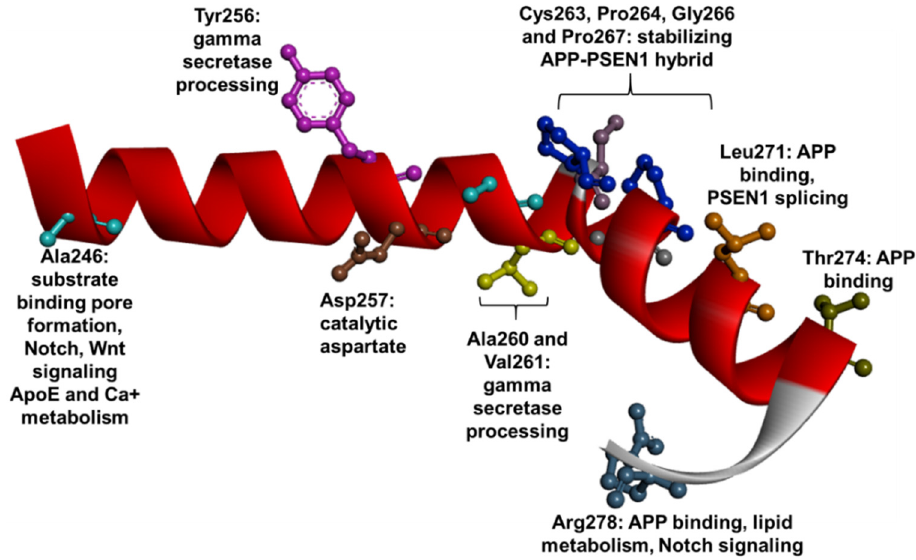
Figure 9 . Significant residues in TM6 and HL6 . Figure 9. Significant residues in TM6 and